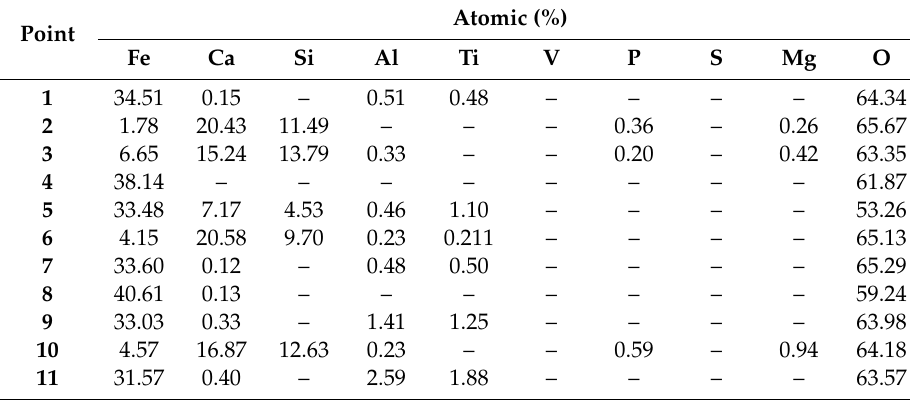
Table 8. EDS analyses for Blend 2 sintered at 1523 K.